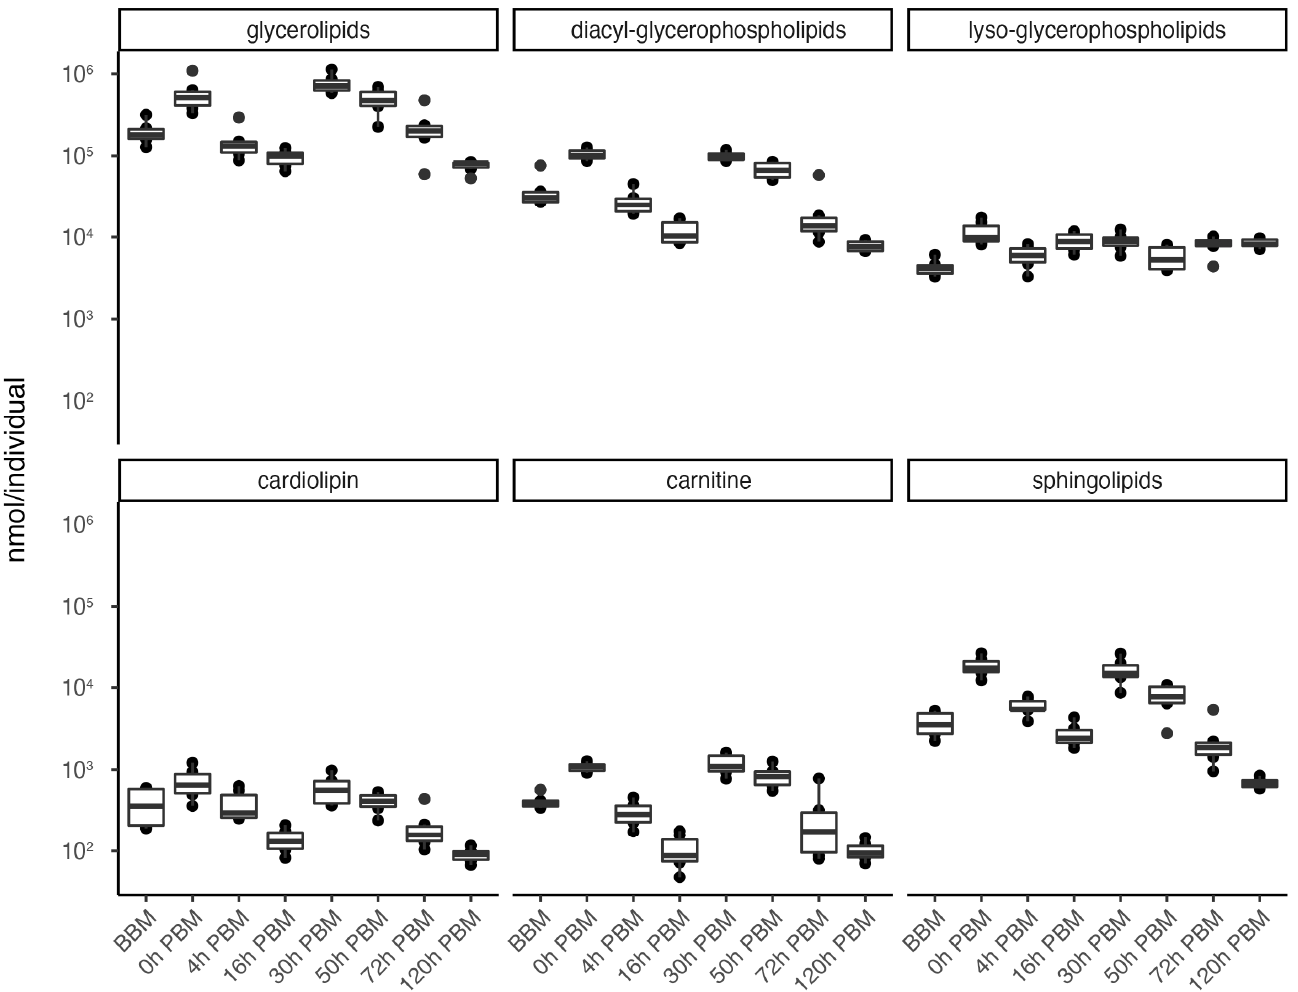
Figure 3. Changes of lipid amounts in Aedes aegypti females over the course of feeding and re- production. The total amount (nmol/individual) of glycerolipids, diacyl-glycerophospholipids, lyso-glycerophospholipids, cardiolipins, carnitines and sphingolipids were measured at eight time points before blood meal (BBM) and post blood meal (PBM). The significant level of differences between BBM and 0h PBM, and between 16 h PBM and 30 h PBM are marked. Unlike lyso-glycerophospholipids, almost all diacyl-glycerophospholipids had signifi- cantly increased, including all ether PI, oxidized PE, PE, PA, PG, PI and PS. In particular, 30 out of 43 PE and 18 out of 33 PI identified increased more than ten-fold. In addition, 42 out of 66 CL increased more than ten-fold and the four HexCer identified increased about ten-fold. In summary, lipids that increased by more than ten-fold include most of the PE, PI and CL, which act as membrane components, and all of HexCer and LPA, which act